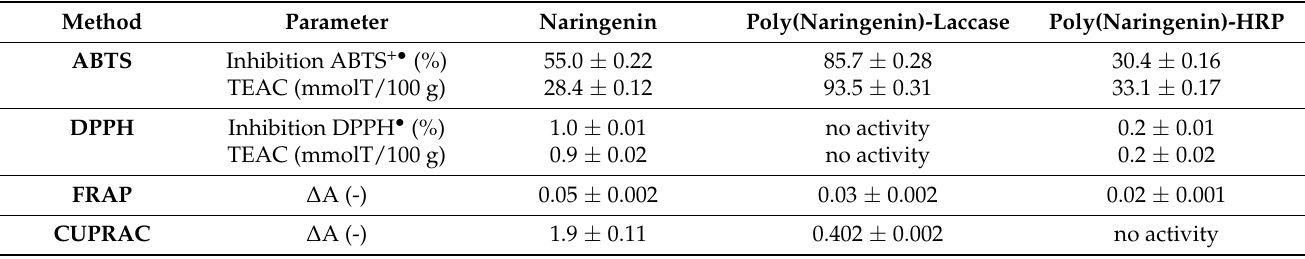
Table 2. The activity of naringenin, poly(naringenin)-laccase and poly(naringenin)-HRP to